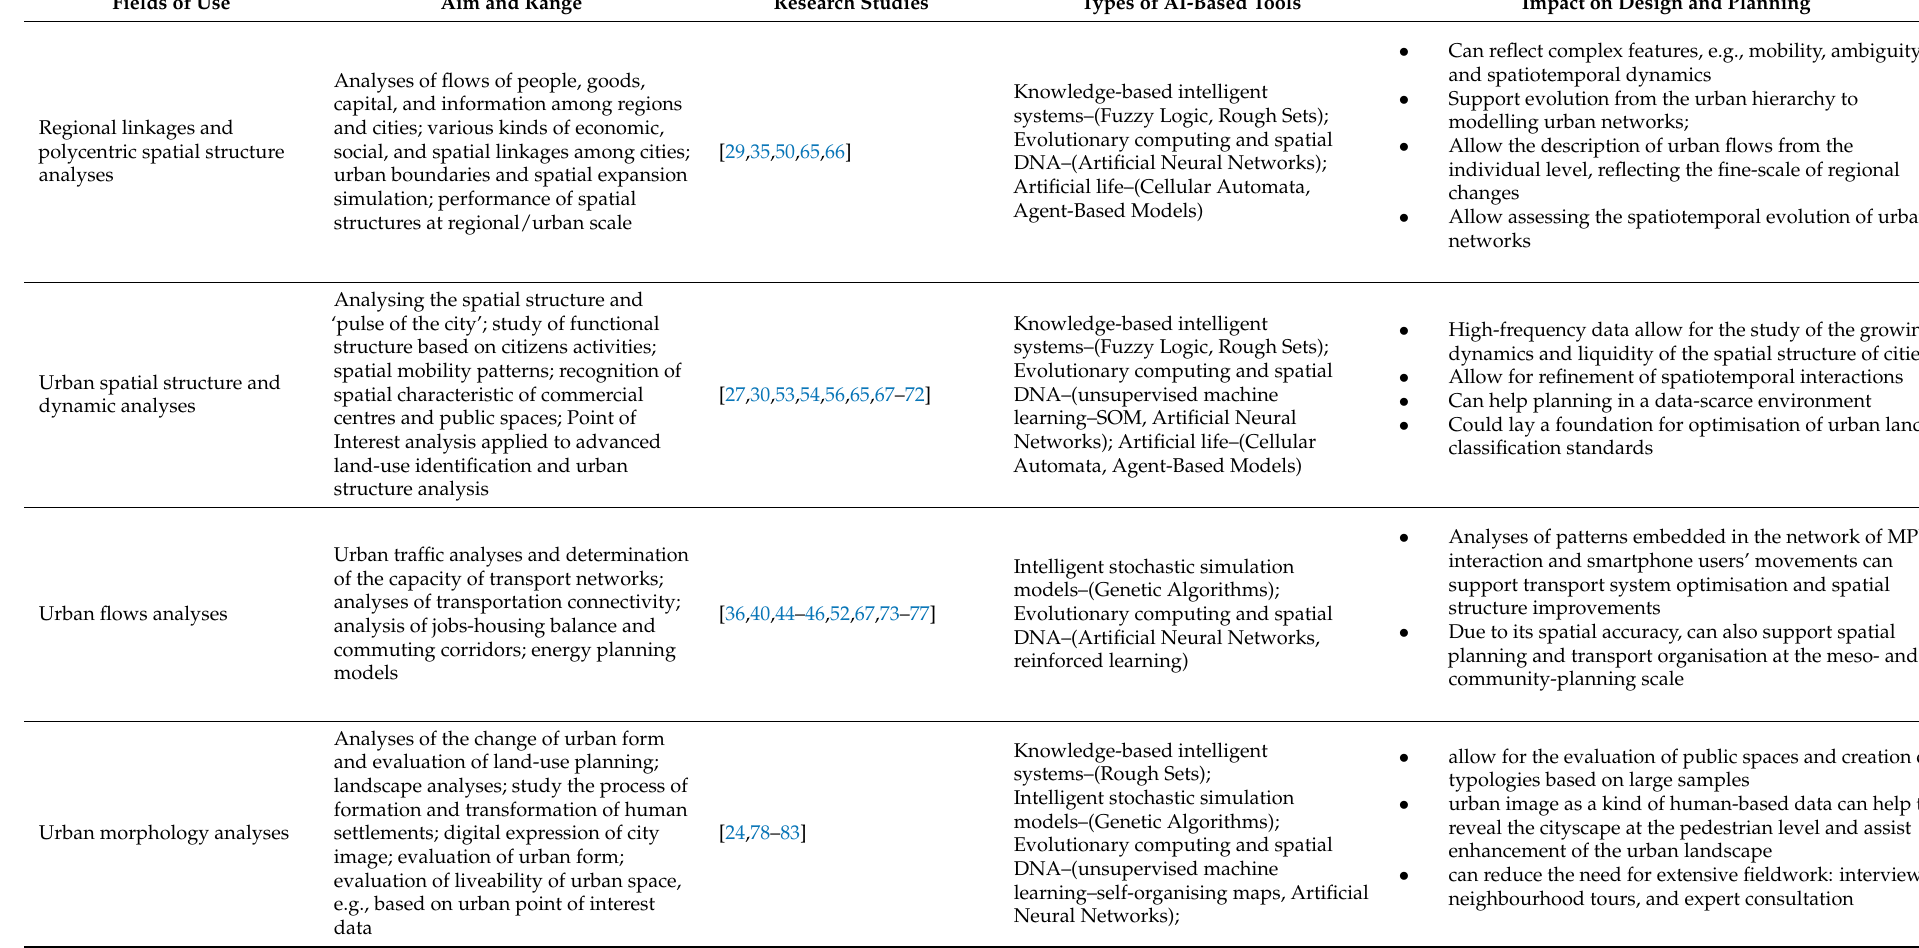
Table 1. Impact of IA algorithm-based tools in the design and planning of